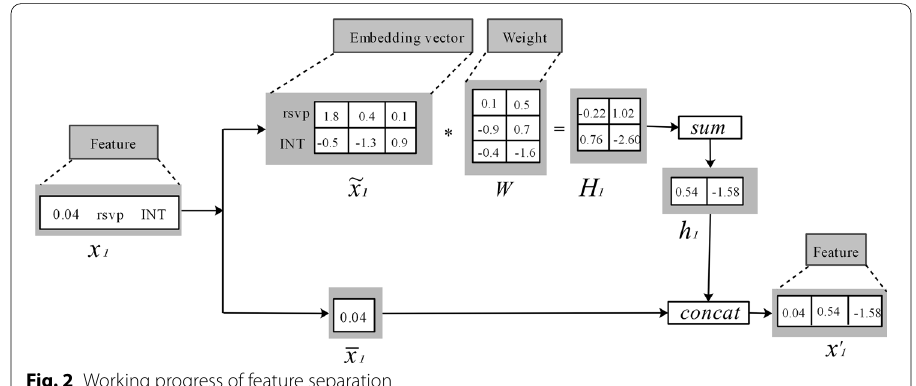
Fig. 2 Working progress of feature separation